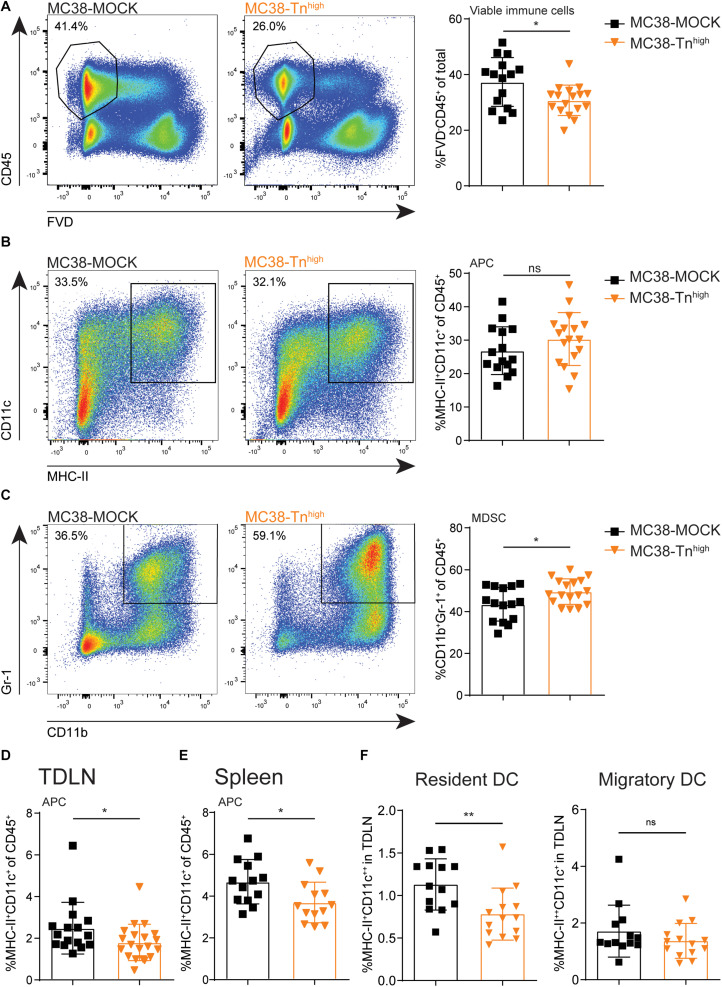
Characterization of myeloid immune cells in Tnhigh tumors. (A–C) Flow cytometric analysis of viable immune cells (FVD– CD45+) (A), antigen presenting cells (APCs, MCH-II+CD11c+) (B) and myeloid derived suppressor cells (MDSCs, CD11b+Gr-1+) (C) at the tumor site. Tumors were harvested when they reached a size of 2000 mm3. (D–F) Flow cytometric analysis of APCs present in tumor draining lymph nodes (TDLN) (D,F) or spleen (E). Data represents pooled data of n = 2 in vivo experiments with n > 5 and n > 8 mice/group (A–D) or one in vivo experiment with n = 13 mice/group (E,F). Mean ± SD; *p < 0.05; **p < 0.01; FVD, fixable viability dye, ns, not significant.